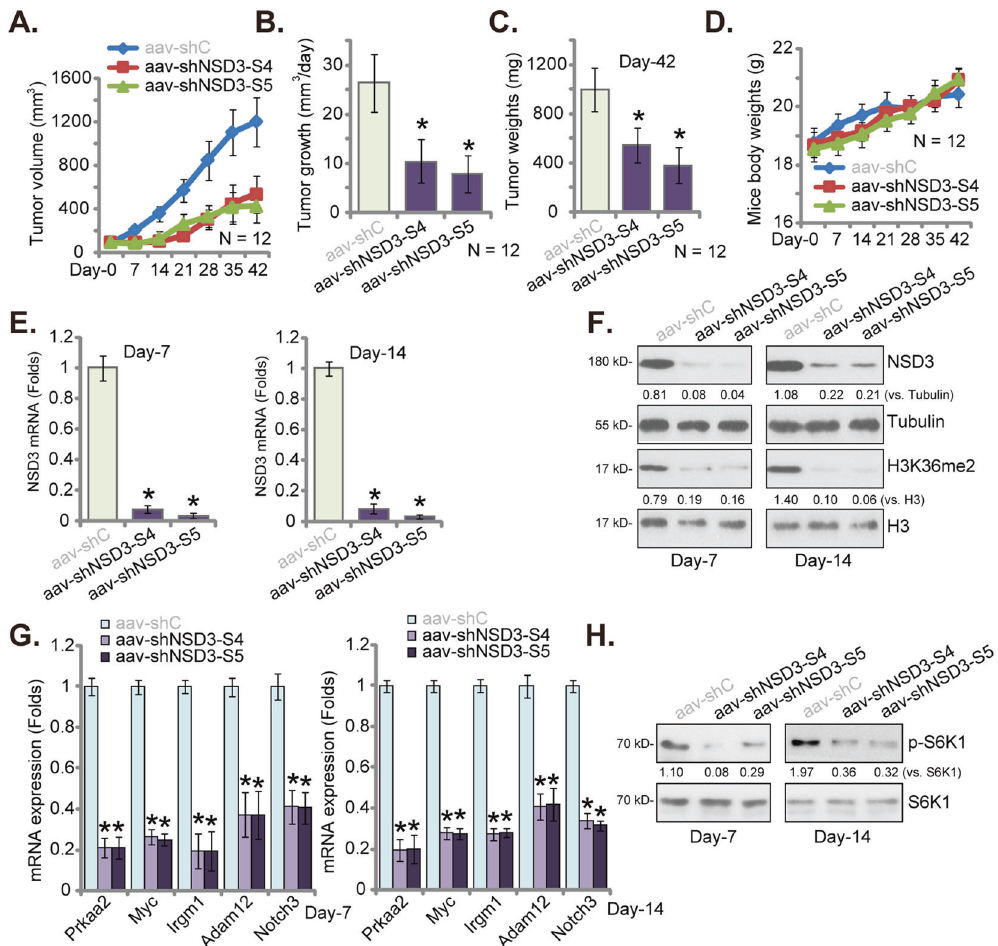
Fig. 7 NSD3 shRNA injection inhibits PanCa-1 xenograft tumor growth in nude mice. The PanCa-1 xenograft-bearing nude mice were subjected to intratumoral injection of AAV-packed shNSD3-S4 ( “ aav-shNSD3-S4 ” ), AAV-packed-shNSD3-S5 ( “ aav-shNSD3-S5 ” ) or AAV-packed shC ( “ aav-shC ” ), daily for 7 consecutive days; tumor volumes ( A ) and mice body weights ( D ) were recorded every 7 days for a total of 42 days. The estimated daily tumor growth, in mm 3 per day, was calculated using the described formula ( B ). All tumors were carefully isolated at Day- 42 and weighted individually ( C ). At Day-7 and Day-14, one tumor of each group was carefully separated and total six tumors were acquired. Expression of listed mRNAs and proteins in tumor tissue lysates were tested by qRT-PCR ( E , G ) and western blotting ( F , H ) assays, respectively. Targeted proteins were quanti fi ed and normalized to the corresponding loading controls ( F , H ). Data were presented as mean ± standard deviation (SD). N = 12 stands for 12 mice per group ( A – D ). * P < 0.05 vs. “ aav-shC ”